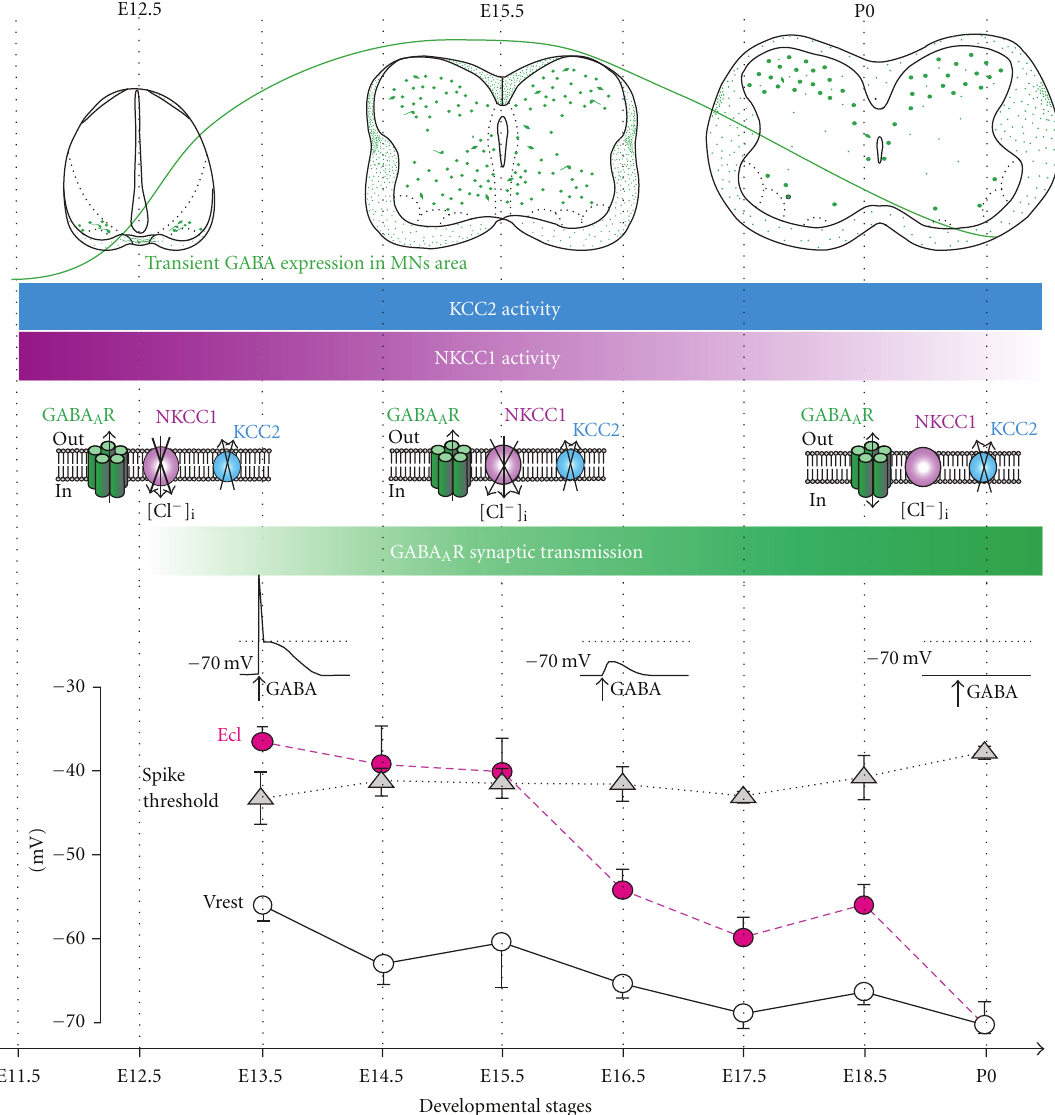
Figure 1: Development of the GABA A R-mediated inhibitory transmission in mouse lumbar spinal MNs. From top to bottom: schematic drawings (frontal views) depict the transient expression of GABA in spinal ventral interneurons (in green), while horizontal bars indicate the permanent KCC2 (in blue) and transient NKCC1 activity (in violet). The color intensity encodes the level of activity. NKCC1 inactivation combined to KCC2 activity leads to a significant decrease in [Cl − ] i and a disappearance of GABA A R-mediated excitatory e ff ects. In parallel to the maturation of the chloride cotransporters KCC2 and NKCC1, the spinal cord starts to convey first synaptic activity at E12.5 that is GABAergic (green horizontal bar). Bottom: maturation of the chloride equilibrium potential ( E Cl ), spike threshold and resting membrane potential (Vrest) across the embryonic stages of developmental. Note the drop of E Cl at E16.5 that accounts for the “shunting” GABA A R- mediated e ff ect (modified from [47, 56,